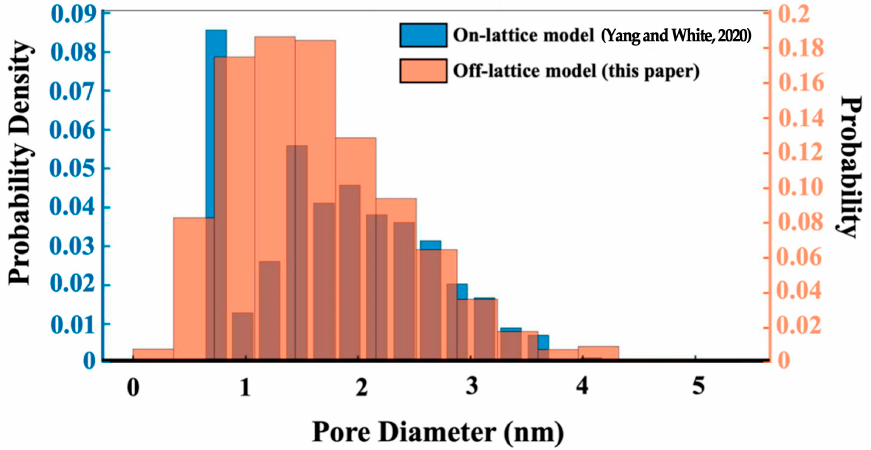
Figure 13. Cluster size distribution from the off-lattice model compared to the on-lattice results from Yang and White’s model [19] after 7 million iterations. Yang and White’s model [19] after 7 million